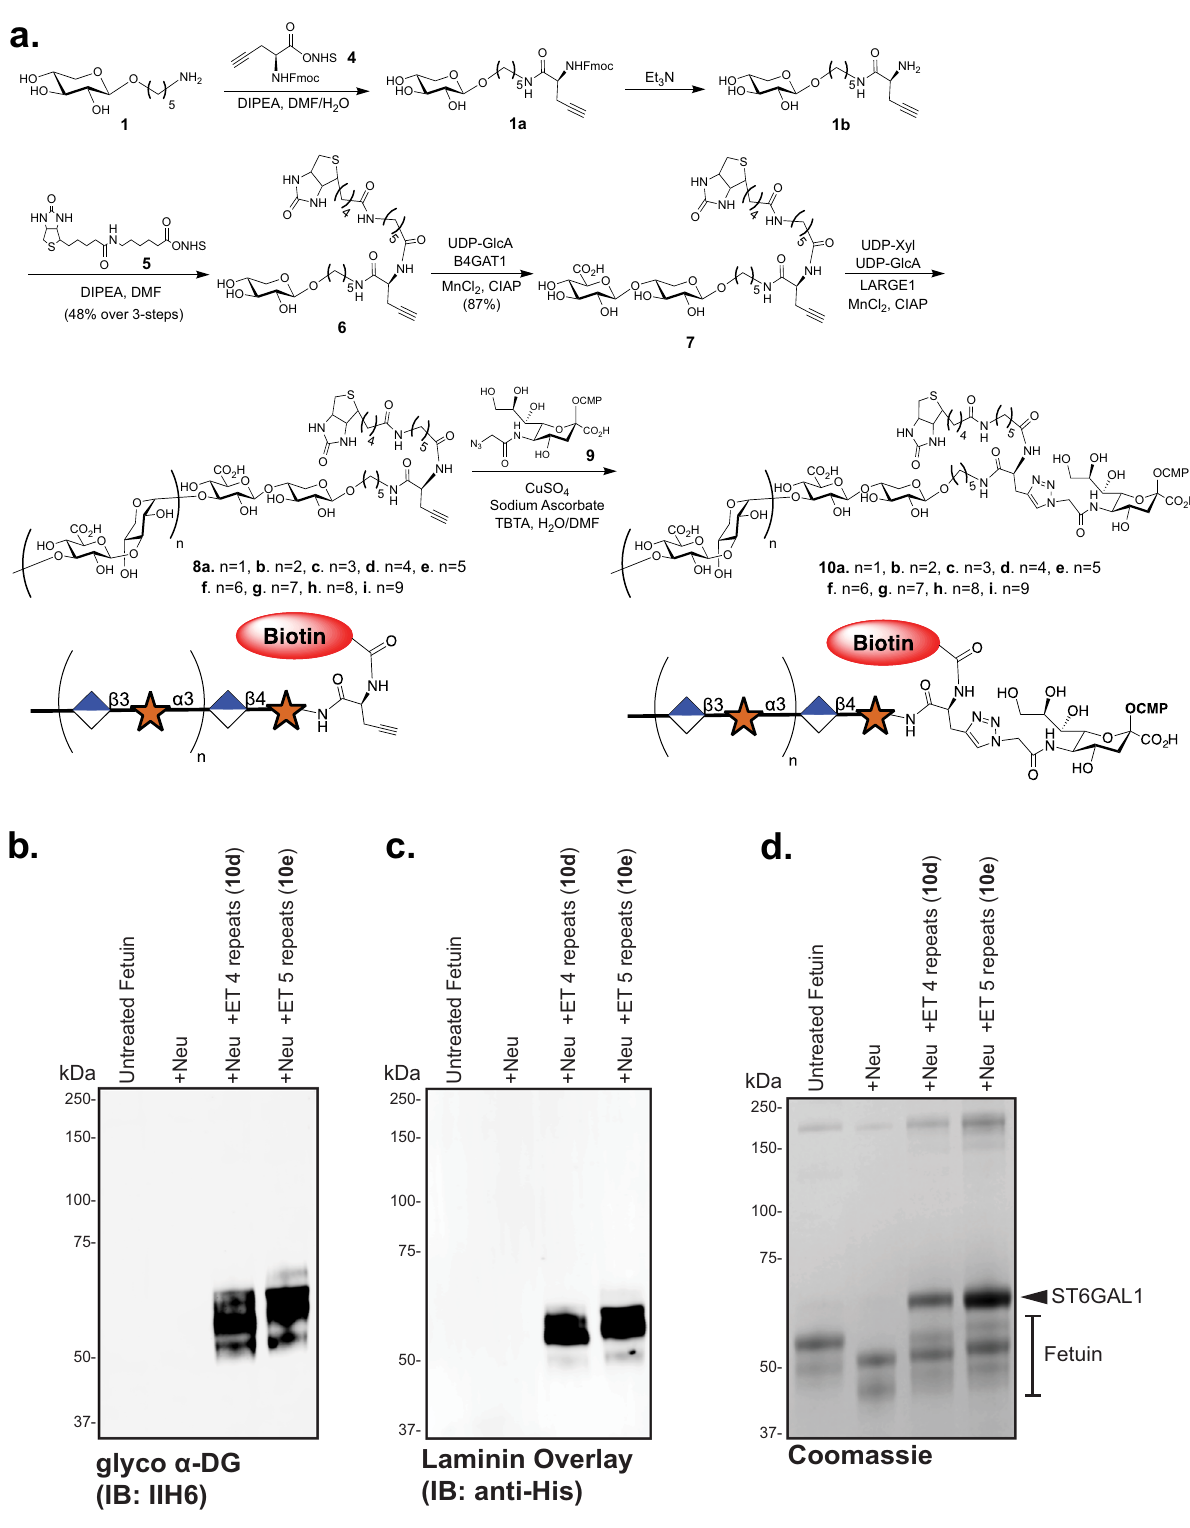
Fig. 3 Synthesis and testing of CMP-Neu5Ac matriglycan compounds for labeling of N-linked glycoproteins. a Chemoenzymatic synthesis of bi- functional CMP-Neu5Ac compounds composed of de fi ned matriglycan polymers and a biotin functionality for protein and cell-surface glyco-engineering. Analyses of the enzymatic transfers (ET) of the synthesized compound show positive labeling of fetuin via reactivity with the anti-glyco- α -DG antibody IIH6 b , introduces the ability to bind recombinant GFP-His-Laminin LG4/5 as determined by an overlay assay c , and retards migration in SDS-PAGE as demonstrated by total protein Coomassie staining d . + Neu + Neuraminidase, + ET Enzymatic Transfer by ST6GAL1 . Three independent experiments were performed with similar results each